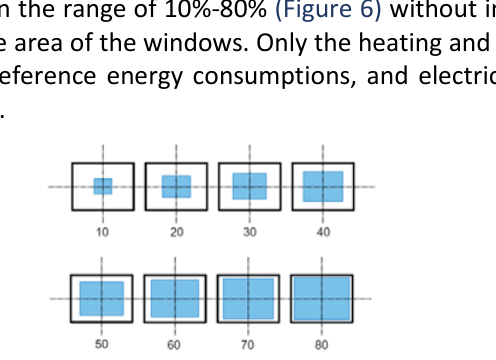
Figure 6 Window wall ratios used in the realistic